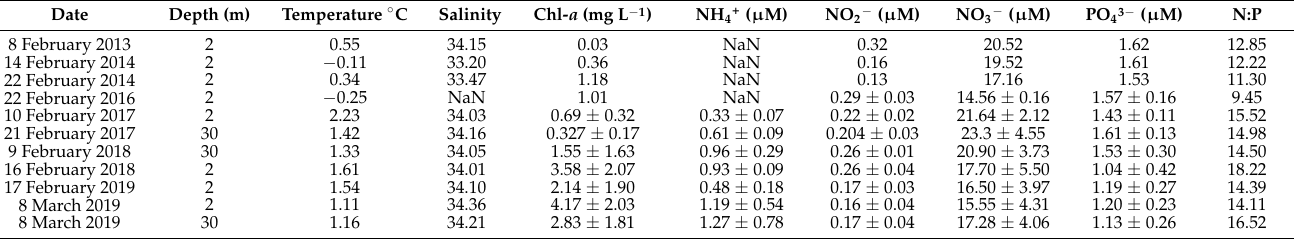
Table 1. Chile Bay physicochemical variables during the late summer periods (February–March) of 2013–2014 and 2016–2019. Inorganic nutrients (NO 3 − , NO 2 − NH 4+ , PO 43 − ) and the N:P ratio [N